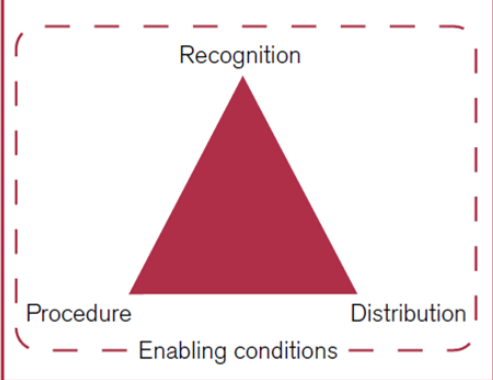
Figure. The three dimensions of equity embedded within a set of enabling conditions